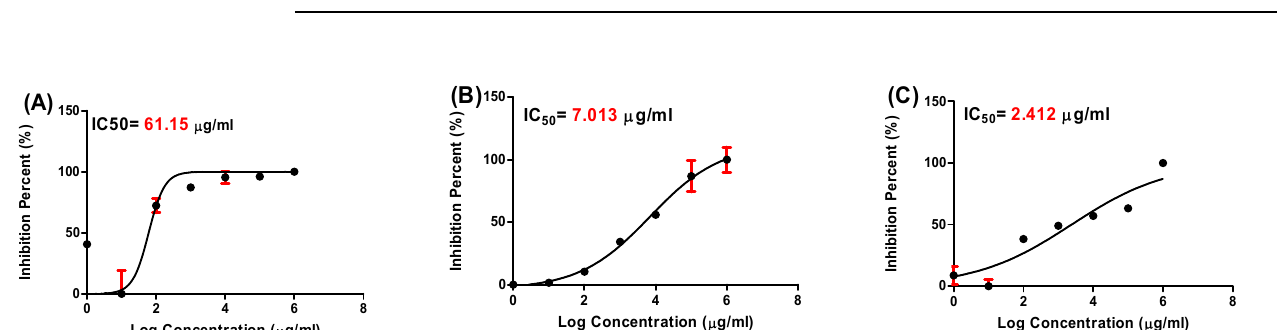
Figure 10. The antiviral effects (IC 50 ) of the compounds tested against the corona 229-E virus. Nonlinear regression analysis was used to create each graph. The log concentrations were plotted against the cell viability normalized response ( A ): C. diurnum L. leaf extract, ( B ): ZnO-NPs, and ( C ): Combination).